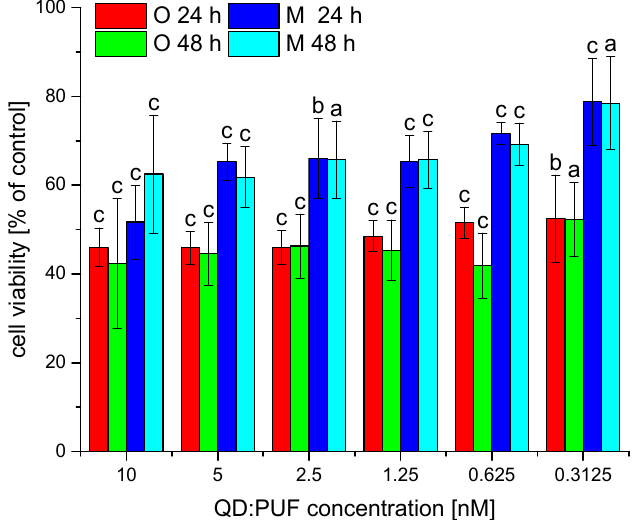
Figure 3. Changes in HeLa cell viability in response to decreasing concentration of QD:Puf in a growth medium. Two different fractions (O, oligomers, and M, monomers) were tested in a series of dilutions. Data show the ratio of average treatment to control, while error bars represent the standard deviation of % of control (calculated as the derivative of individual SD of treated and control samples). Letters a, b and c indicate a statistically significant difference between given condi- tions and control (no QD:Puf) at p < 0.05, p < 0.01 and p < 0.001, respectively.